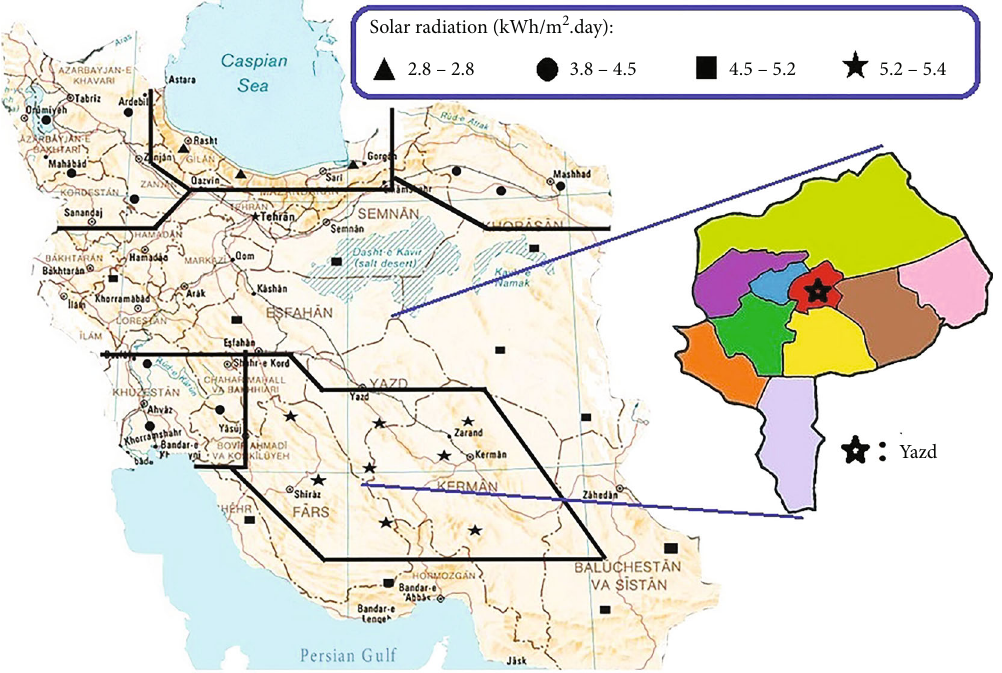
Figure 1: The location of Yazd Province and Yazd City in the solar radiation map of Iran. Table 1: Technical and economic speci fi cations of the